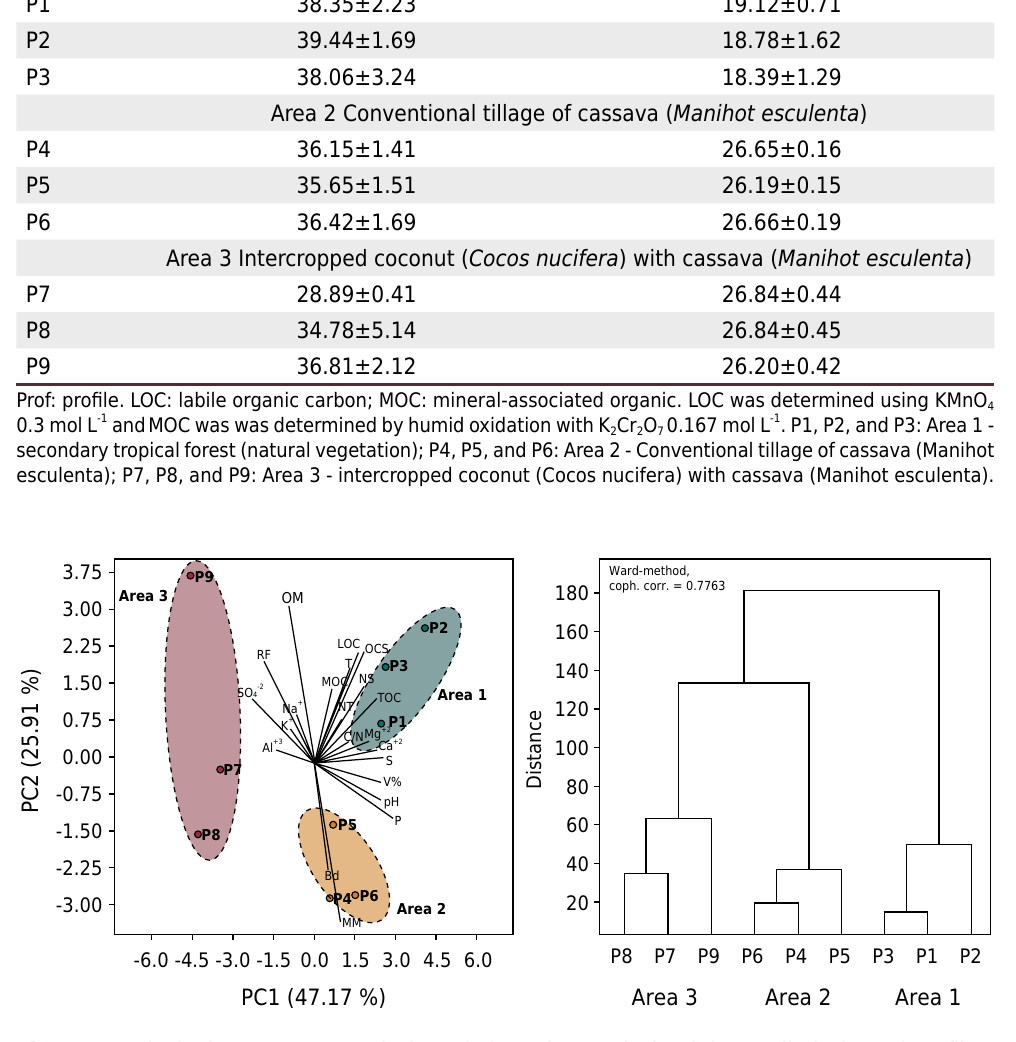
Figure 6. Principal component analysis and clustering analysis of the studied Histosol profiles. P1, P2, and P3: Area 1 - secondary tropical forest (natural vegetation); P4, P5, and P6: Area 2 - Conventional tillage of cassava ( Manihot esculenta ); P7, P8, and P9: Area 3 - intercropped coconut ( Cocos nucifera ) with cassava ( Manihot esculenta